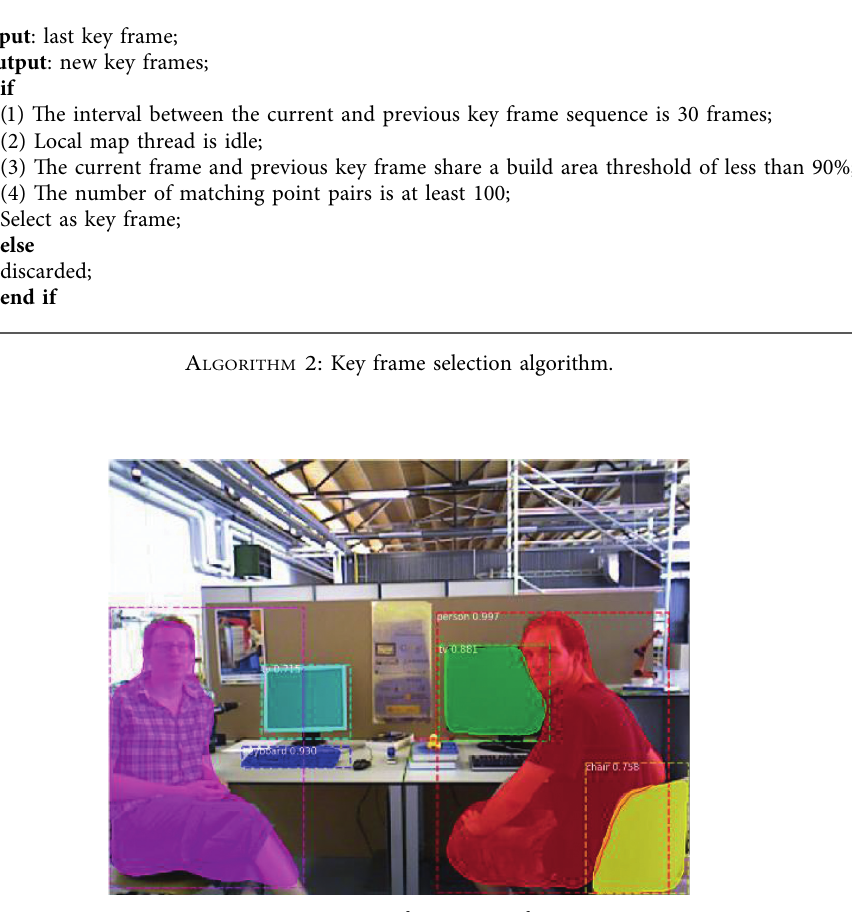
Figure 5: Acquisition of semantic information.